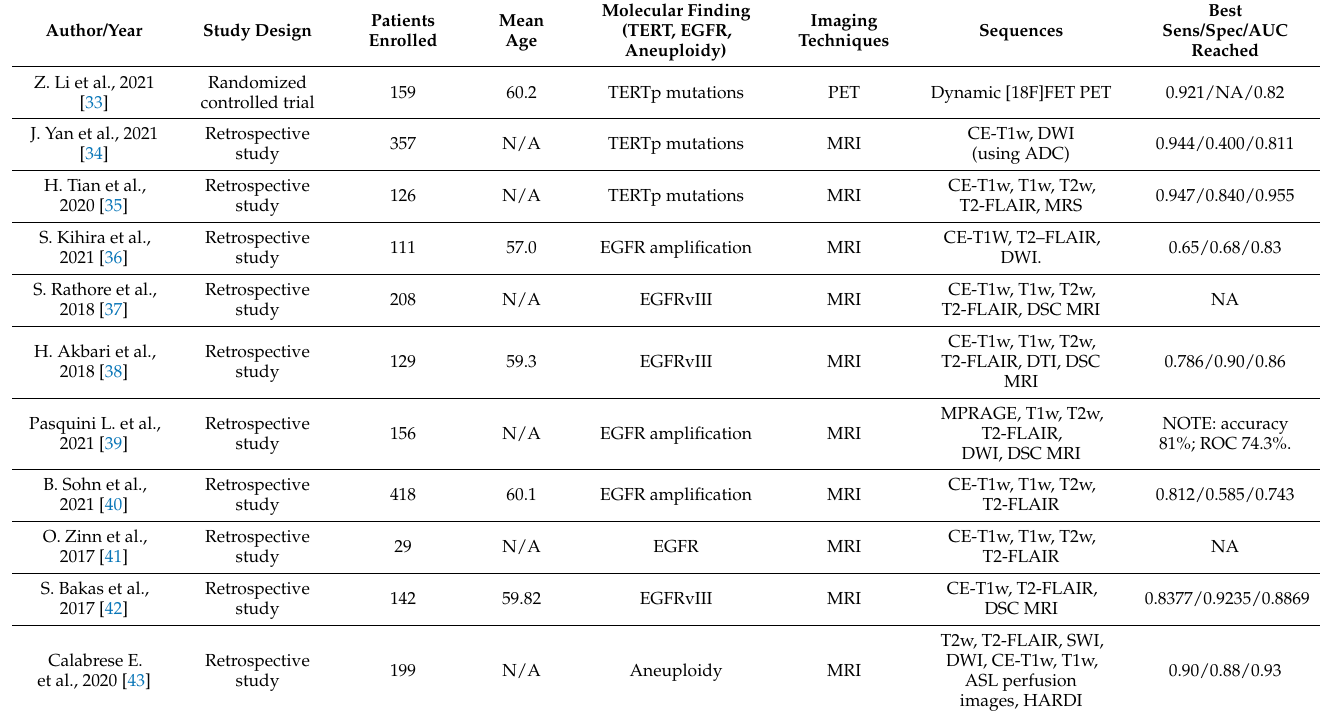
Table 1. Synthesis and comparison of the papers selected and included in review after application of the PRISMA flow